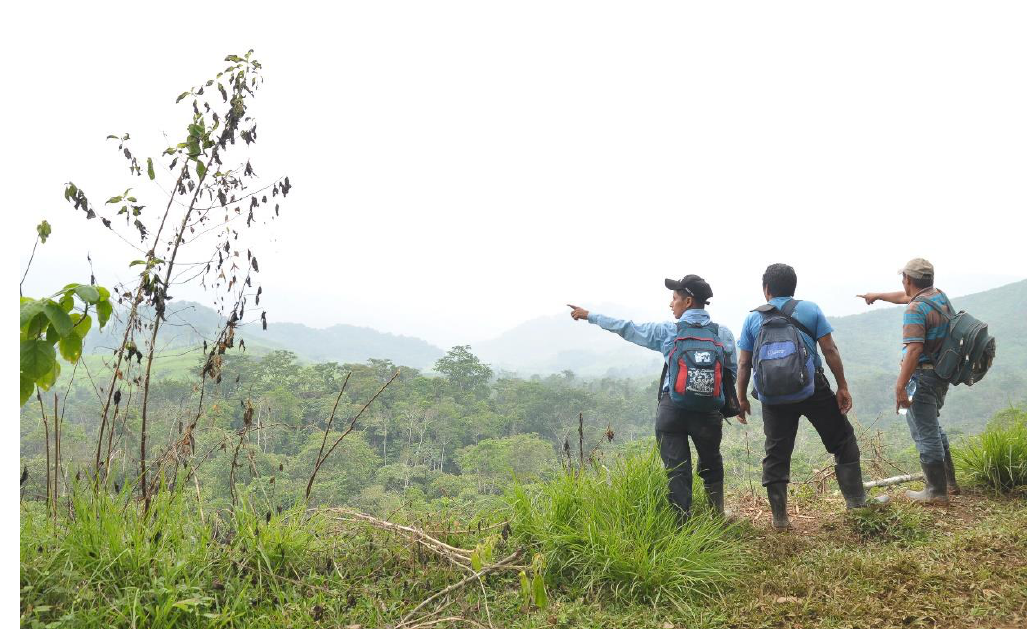
Figure 4. One of the areas to be flooded by the Xalalá dam project (credit: Lieselotte Viaene, 2014).